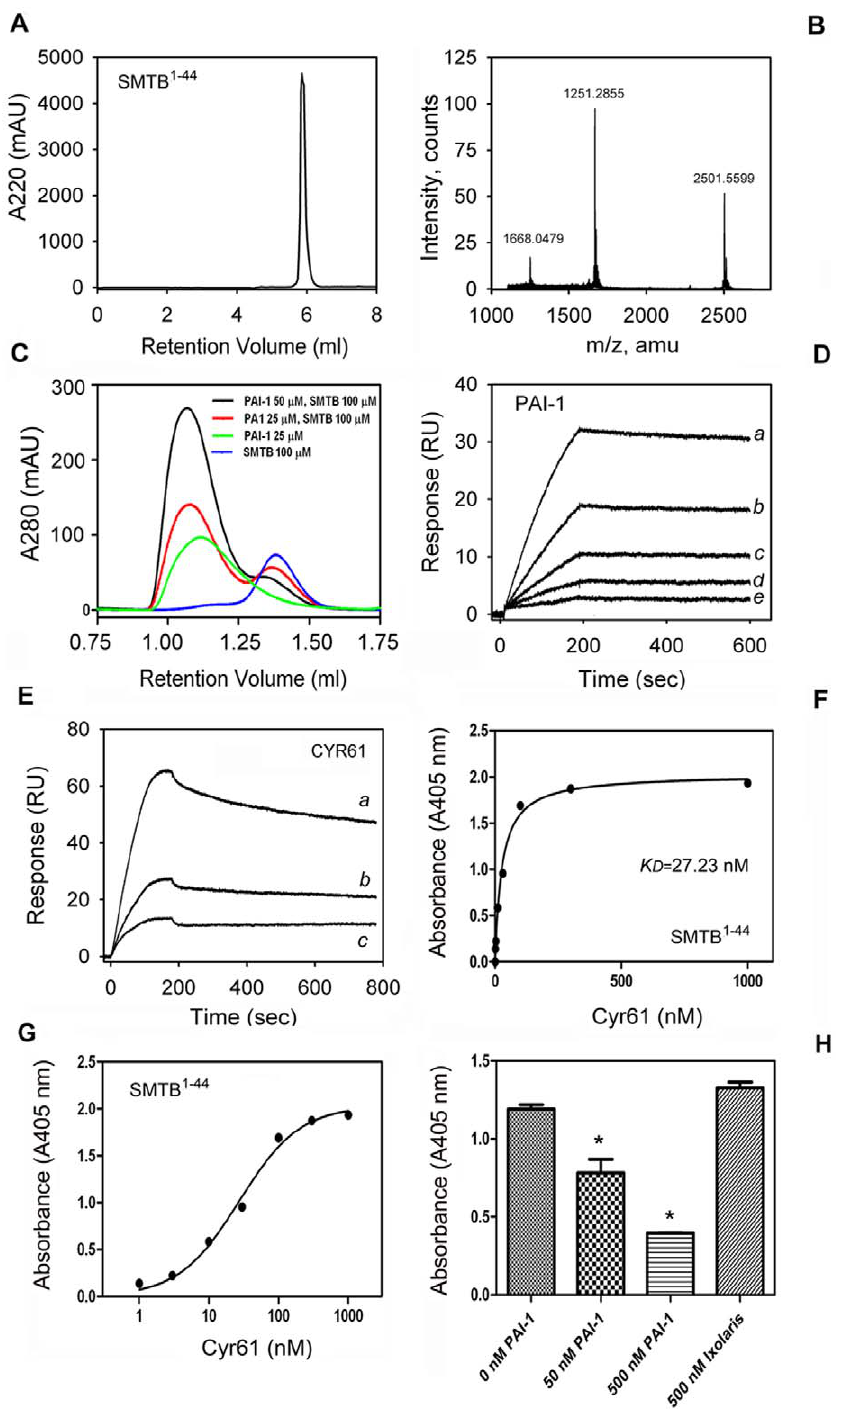
Figure 3. Cyr61 displays high-affinity binding to SMTB 1–-44 domain. ( A ) SMTB 1–44 was chemically synthesized and purified by reverse-phase chromatography. ( B ) Mass spectrometry for the synthetic peptide shows the expected mass for SMTB 1–44 . ( C ) Gel-filtration chromatography shows complex formation between PAI-1 and SMTB 1–44 was performed as in Materials and Methods. ( D ) SPR experiments. Sensorgrams shows PAI-1 (in nM: a , 1.8; b , 0.9; c , 0.45; d , 0.225; e , 0.11) binding to immobilized SMTB 1–44 domain. ( E ) Sensorgrams show Cyr61 (in nM: a , 12.5; b , 6.25; c , 3.1) binding to the SMTB 1–44 domain. Data were fitted using global two-state binding model. RU, resonance units. ( F ) Solid-phase binding assay. Cyr61 (0–1 m M) was incubated with immobilized SMTB 1–44 and binding estimated with anti-Cyr61 monoclonal antibody, followed by alkaline phosphatase-labeled anti- mouse secondary antibody and appropriate substrate as described in Materials and Methods. ( G ) Semi-log transformation of the results presented in ( F ). The (apparent) K D values for Cyr61/ SMTB 1–44 interactions were calculated by nonlinear regression analysis of the binding data according to the Langmuir isotherm equation. ( H ) Competition experiments. Cyr61 (30 nM) was incubated with 0, 50, and 500 nM PAI-1, or 500 nM ixolaris. Mixtures were added to SMTB 1–44 -coated wells and incubated for 90 minutes. SMTB 1–44 -bound Cyr61 was estimated as in ( E ). Experiments were performed in quadruplicate or quintuplicate (n=3).